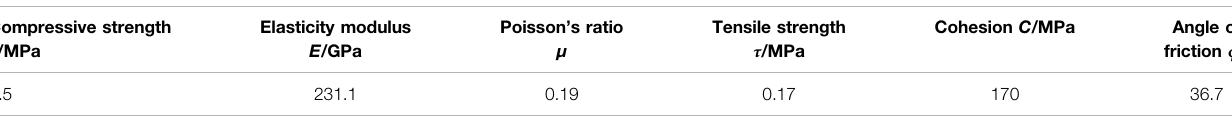
TABLE 2 | Mechanical properties of back fi ll